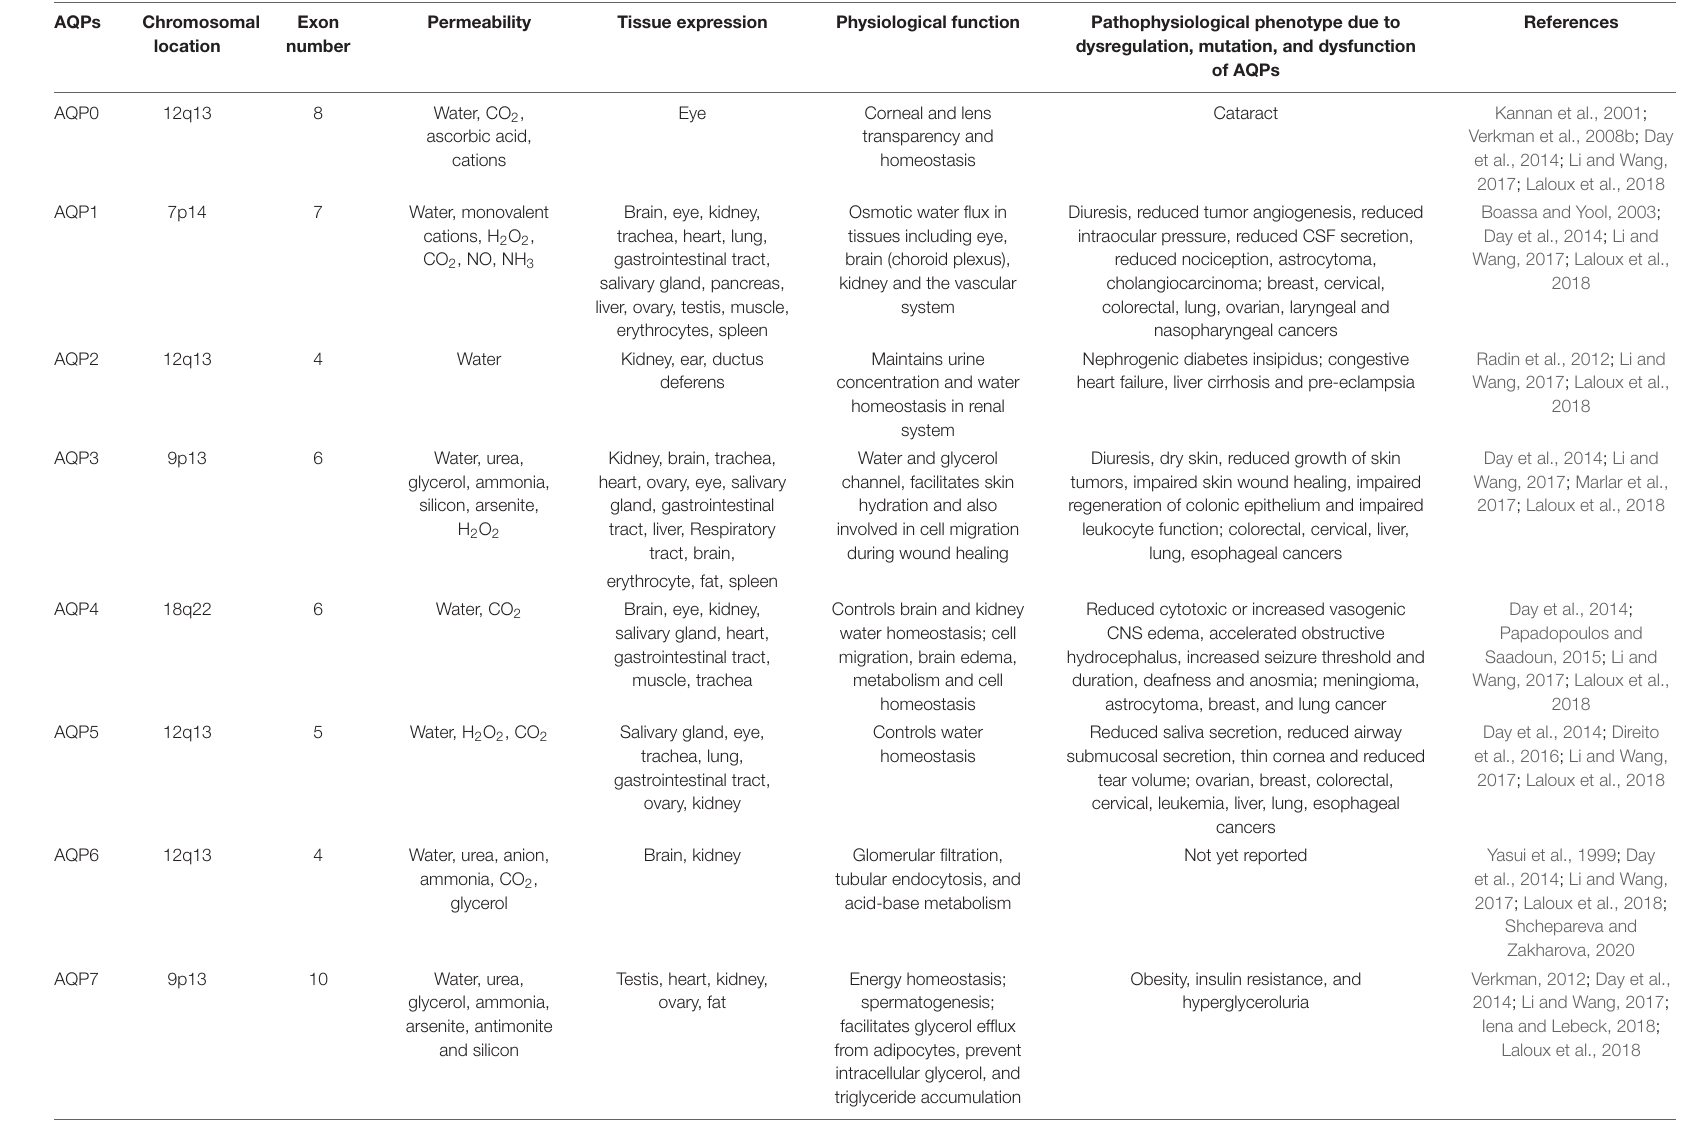
TABLE 1 | Human AQPs major characteristics from chromosomal location to physiological relevance with the pathophysiological phenotypes due to their dysregulation, mutation, and